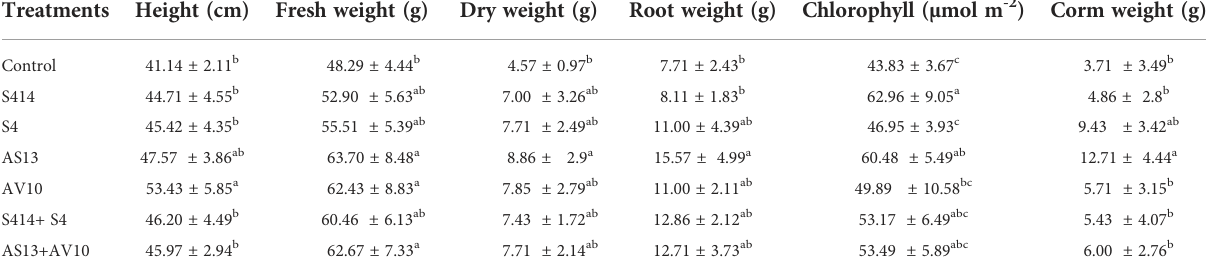
TABLE 4 Effect of bacterial strain inoculation on growth parameters of taro plants 30 days post-treatment under greenhouse conditions. Treatments